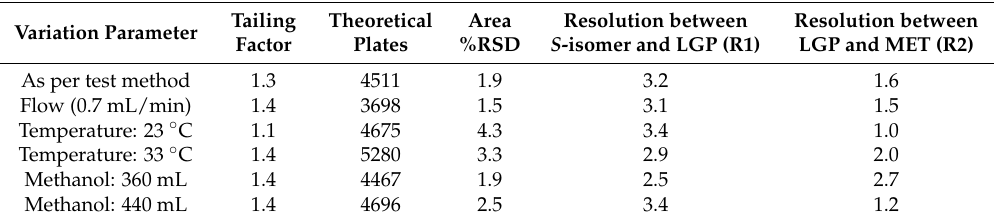
Table 5. Results of